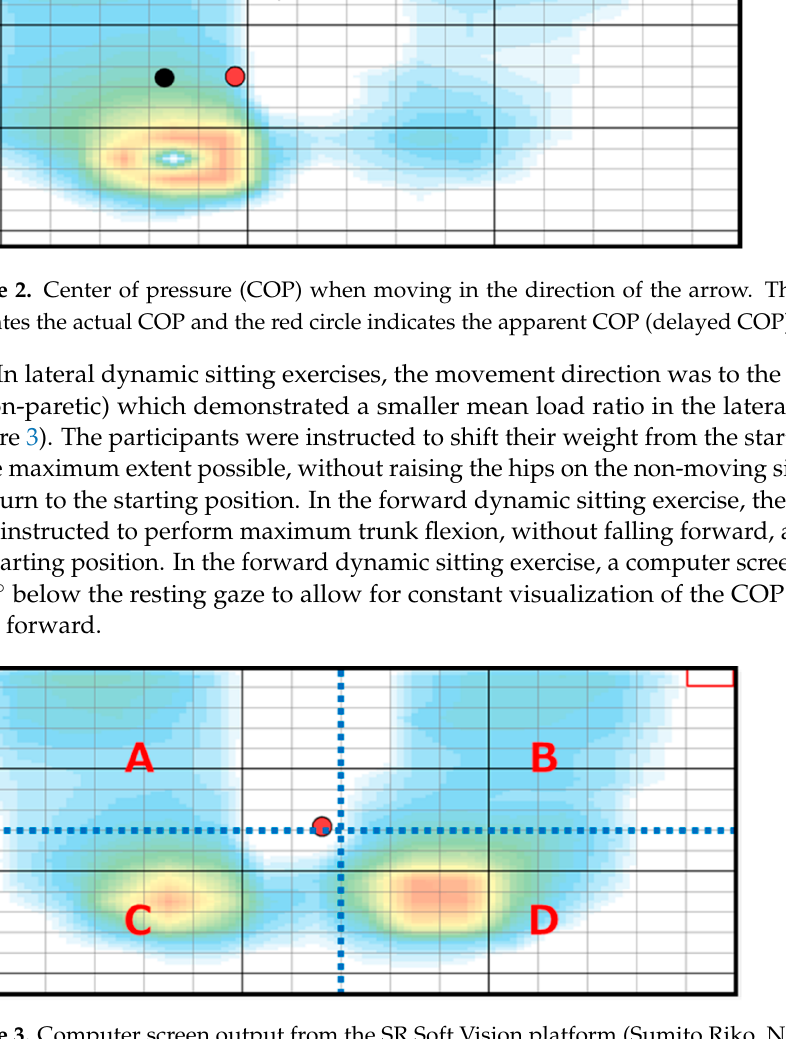
Figure 3. Computer screen output from the SR Soft Vision platform (Sumito Riko, Nagoya, Japan). The mean percentage body weight (BW) on the paretic side in the static sitting task, the mean percentage BW of the moving side in the lateral sitting task, and the mean percentage BW of the anterior direction in the forward sitting task were calculated from the amount of load in each of the A–D regions.